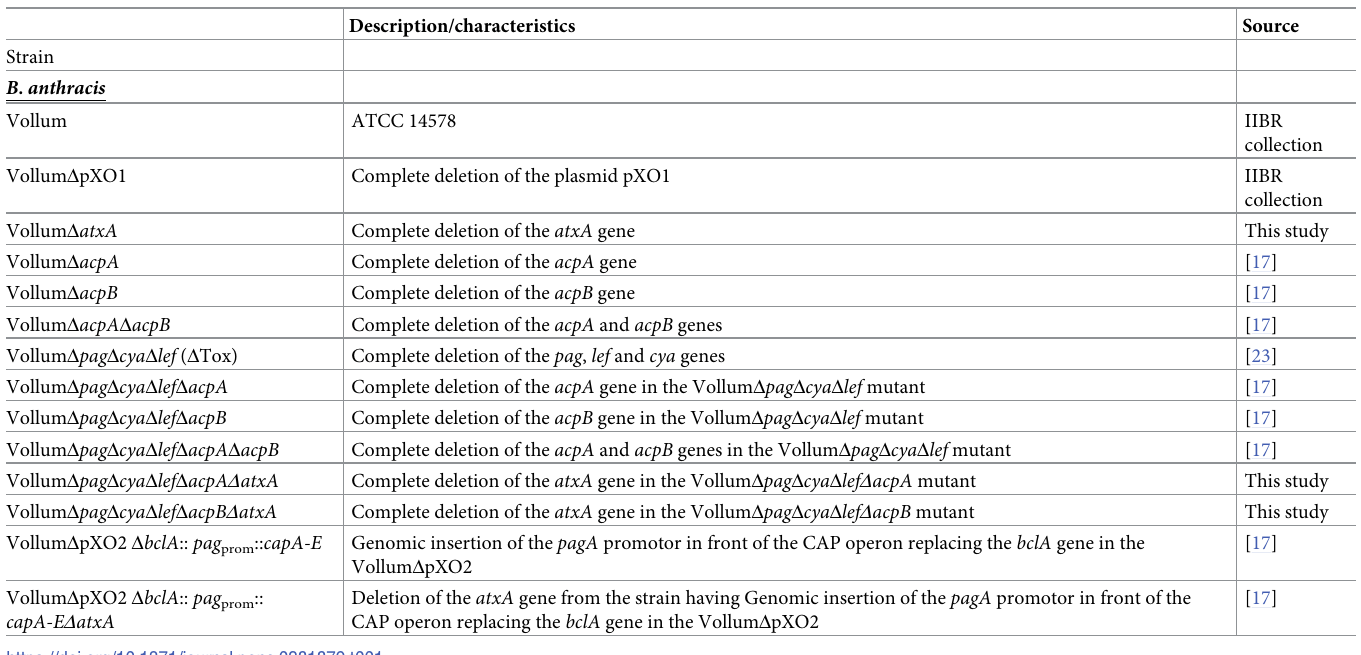
Table 1. Bacterial strains used in this